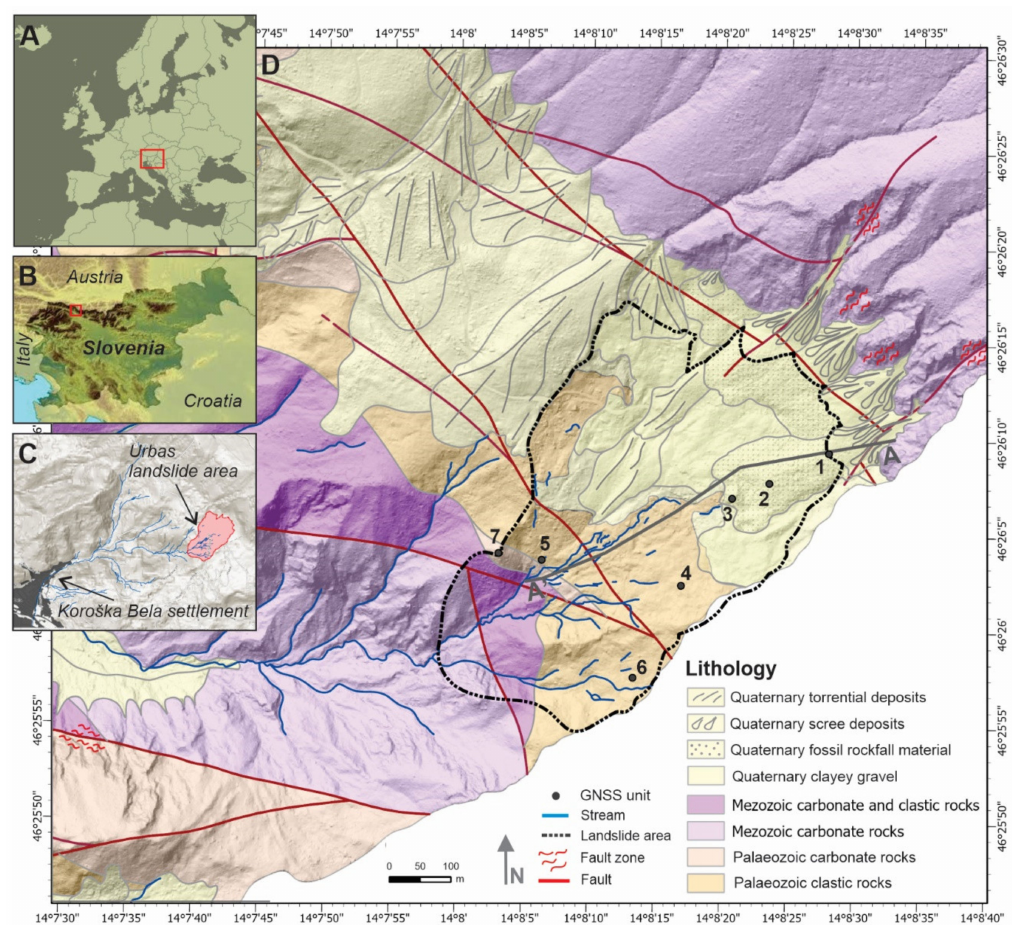
Figure 1. ( A – D ) Location and geology of the wider Urbas landslide area. The geology of the region is adapted from Peternel et al.